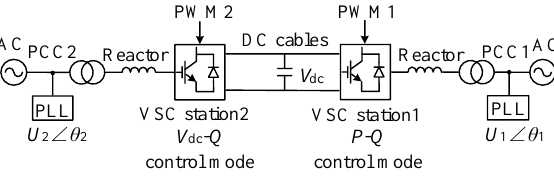
Fig. 1. A simplified diagram for the VSC-HVDC system.